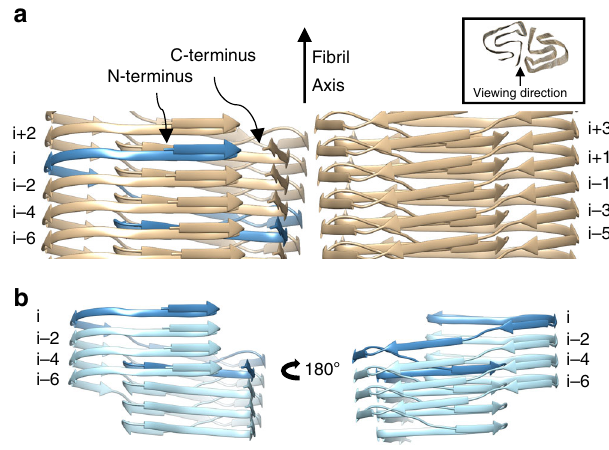
Fig. 5 Side view of the secondary structure of the atomic model. a Single subunit i highlighted in blue with adjacent subunits in beige, described by even numbers, while the subunits of the opposite proto fi lament are described by odd numbers. b View of the minimal fi bril unit ( i ) to ( i -6) in one fi lament. The minimal fi bril unit is displayed from two views by a turn of 180° highlighting the course of one monomer spanning several fi bril layers